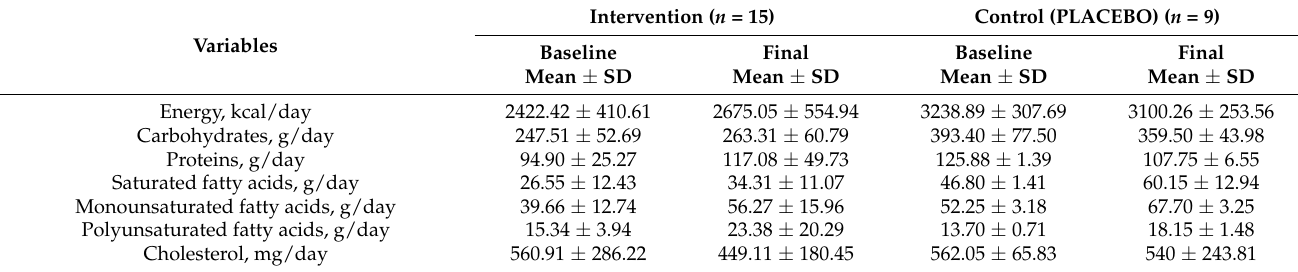
Table 4. Result of the 3-day dietary survey at baseline and at the end of the